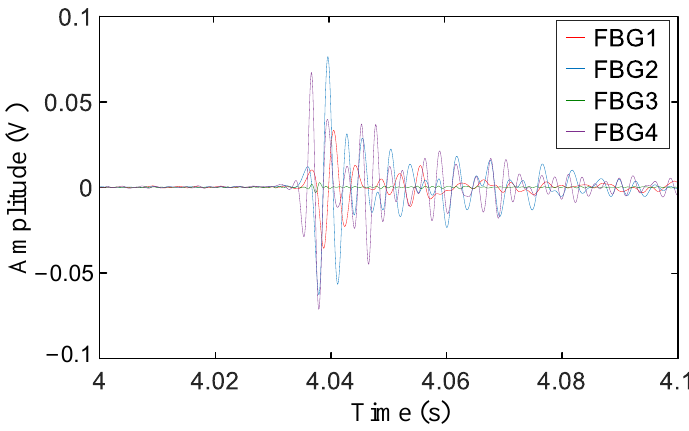
Figure 8. The reconstructed signals.